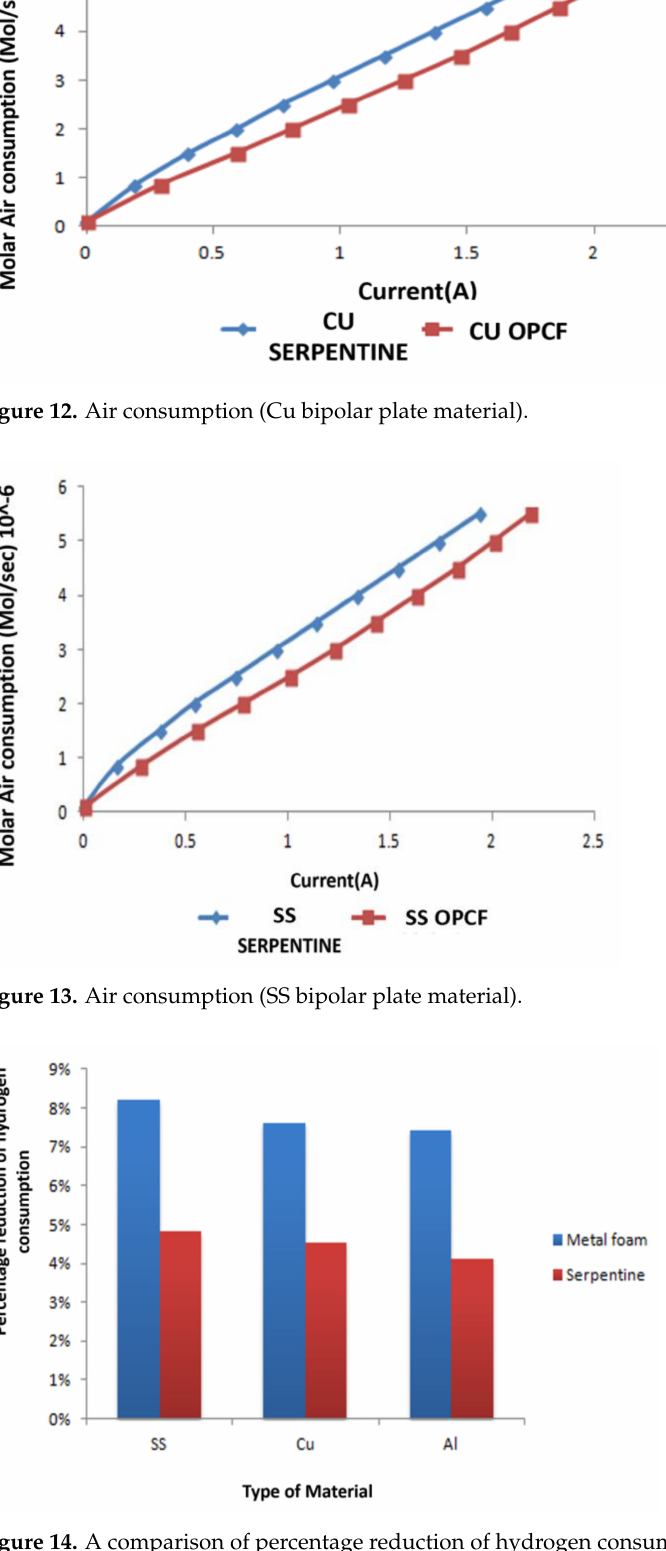
Figure 14. A comparison of percentage reduction of hydrogen consumption between Al, Cu and SS bipolar plate material between metal foam and serpentine flow